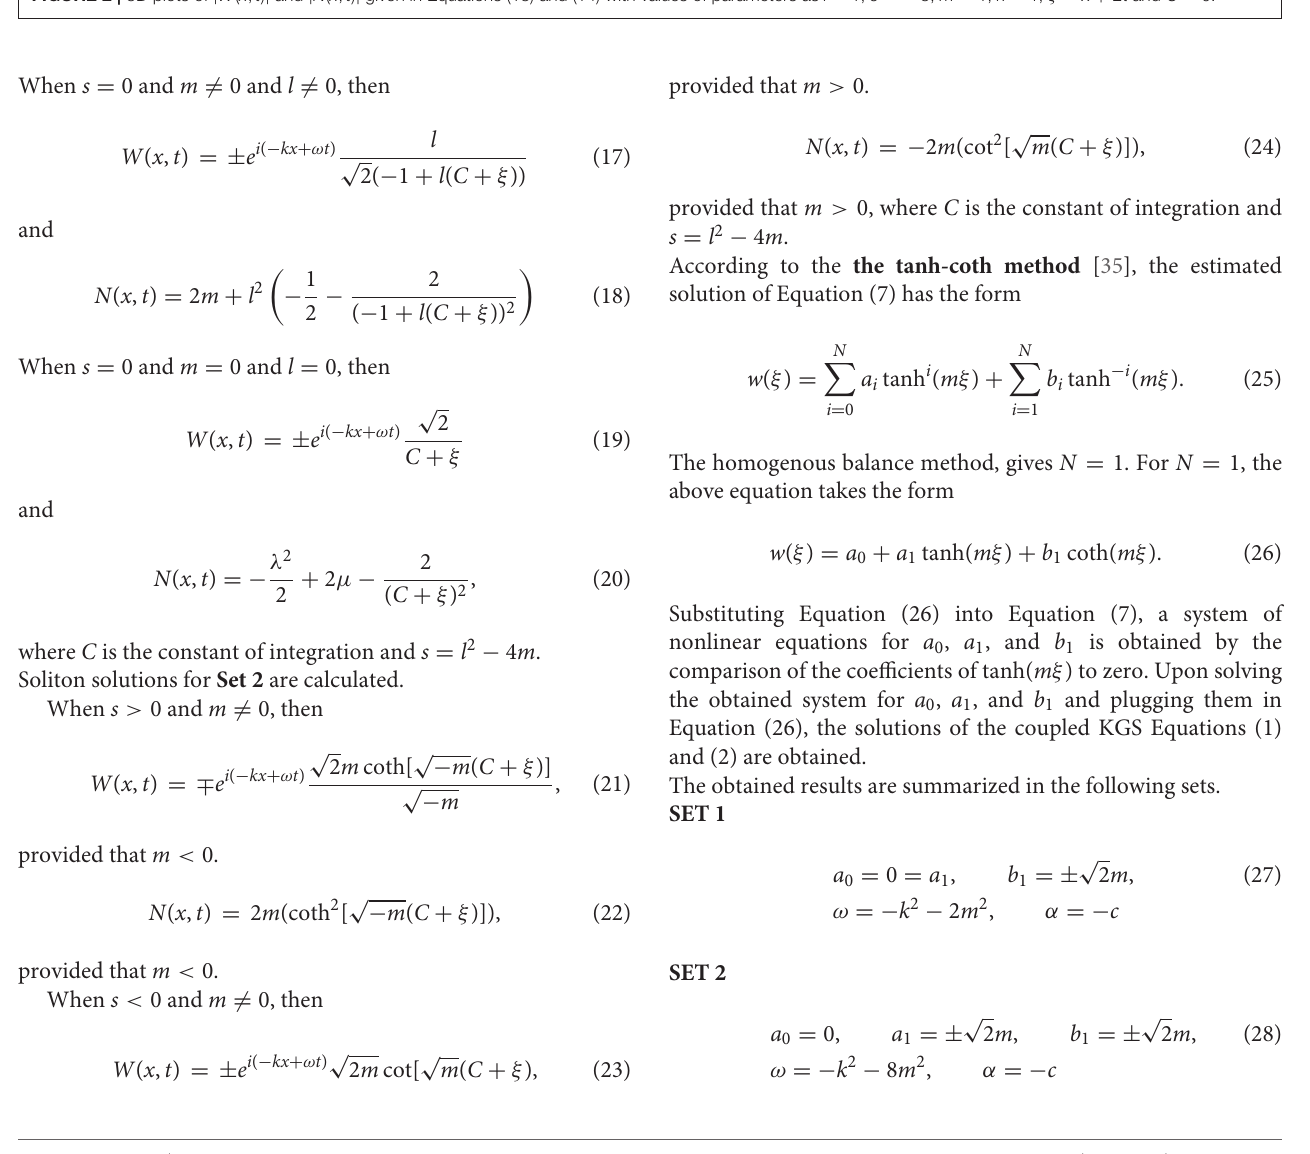
FIGURE 2 | 3D plots of